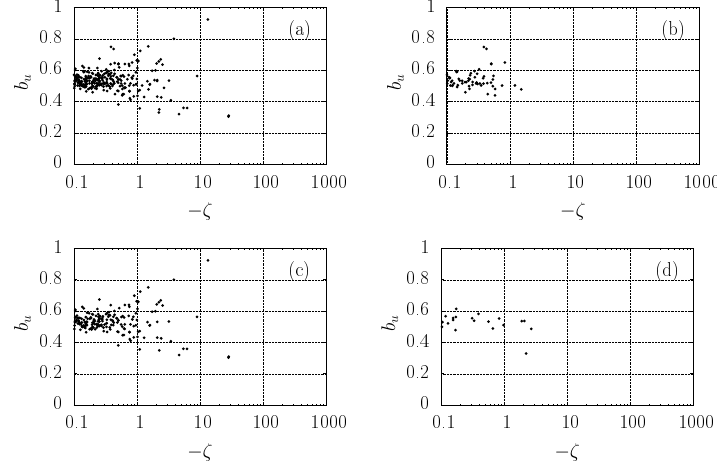
Figure 14. The behavior of b u at 39.4m against Obukhov’s stability variable ζ and zenith angle Z in the RSL: (a) all data; (b) 0 ◦ < | Z |≤ 20 ◦ ; (c) 20 ◦ < | Z |≤ 60 ◦ ; and (d) 60 ◦ < | Z |≤ 90 ◦ . Table 5. Statistics for b u (from REA) at 39.4m. All